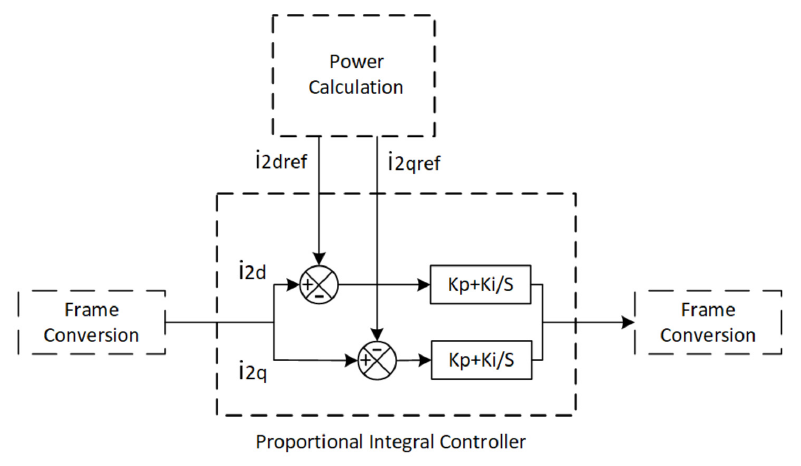
Figure 4. PI controller adopted in the system.